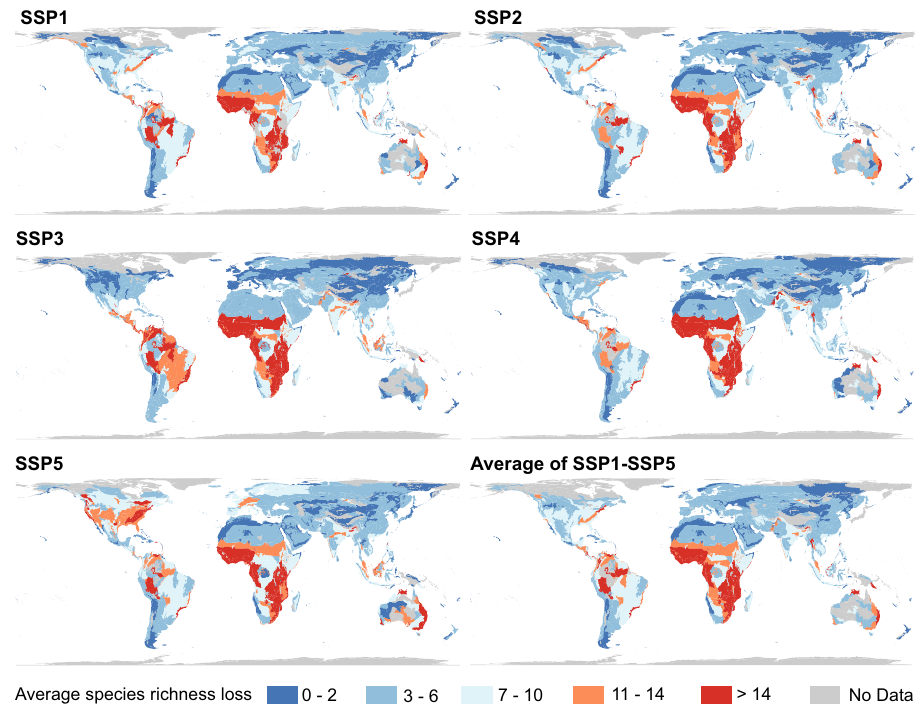
Fig. 5 Average potential biodiversity loss per 10 km grid cell in ecoregions due to future urban expansion under SSP scenarios. The mean potential biodiversity loss represents the average number of terrestrial vertebrate species (amphibians, mammals, and birds) lost per 10 km grid